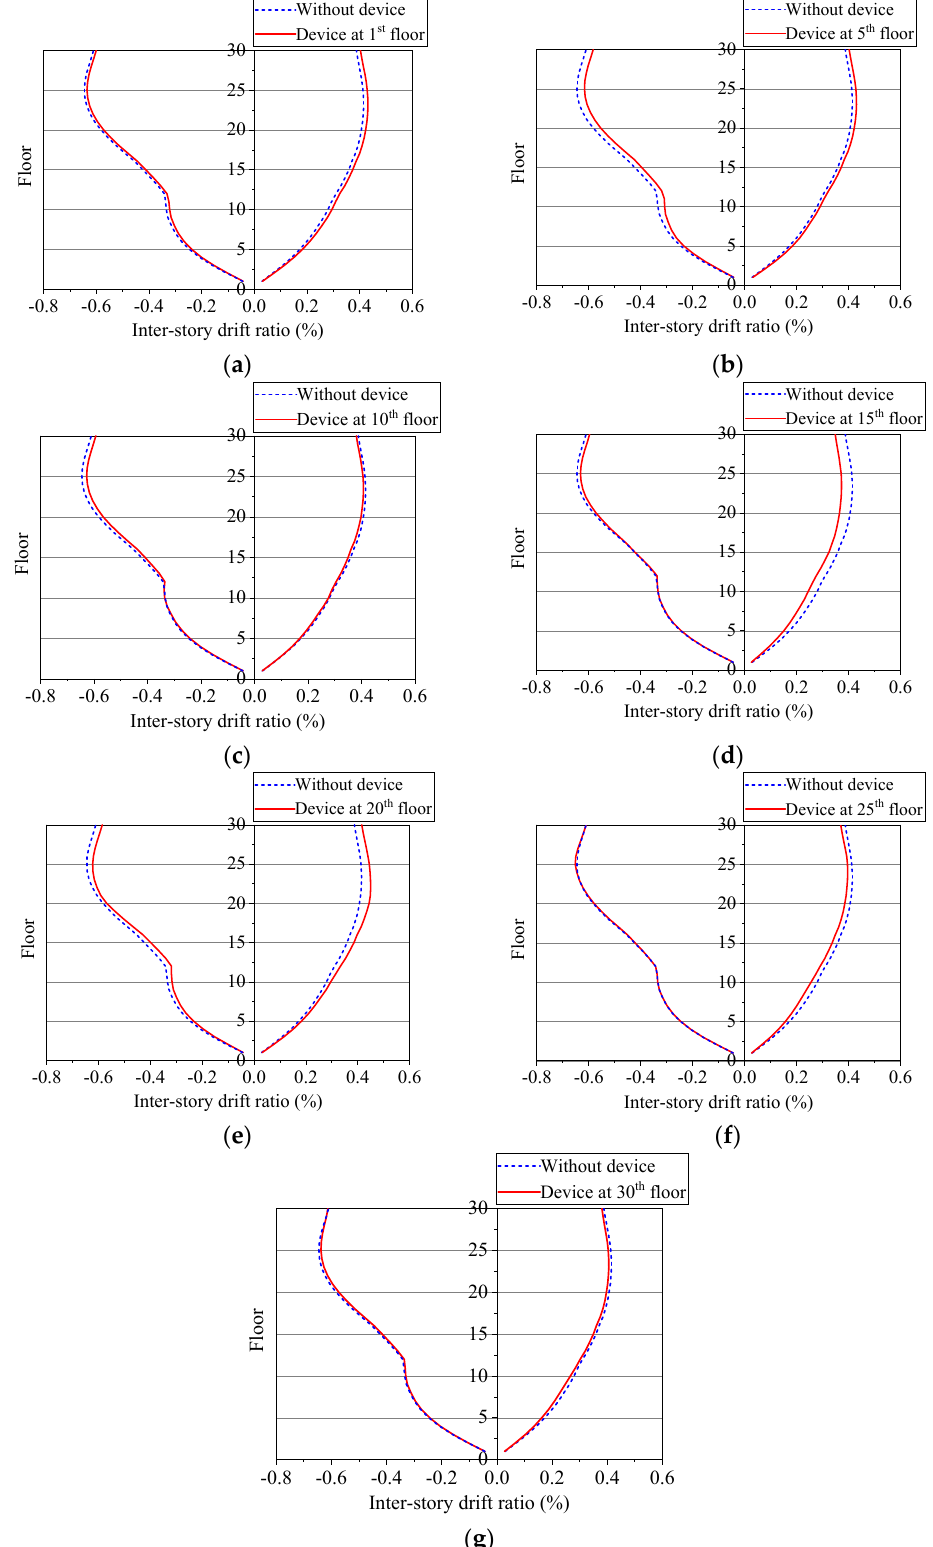
Figure 20. Inter-story drift ratio of structure when one device assigned at: ( a ) 1st floor; ( b ) 5th floor; ( c ) 10th floor; ( d ) 15th floor; ( e ) 20th floor; ( f ) 25th floor; ( g ) 30th floor.